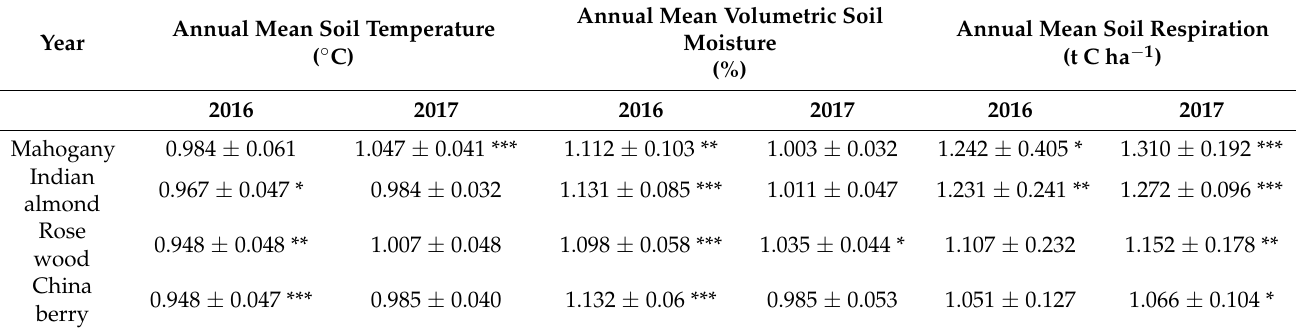
Table 2. Average relative ratio of the annual means of the environmental factors in 2016–2017 to that in the pretyphoon disturbance years for the four tree species: mahogany, Indian almond, rose wood, and China berry. The averages of the factors in the post-typhoon disturbance year (2017) were also compared with those of the pretyphoon disturbance year (2015). Values indicate means ± standard deviations ( n =